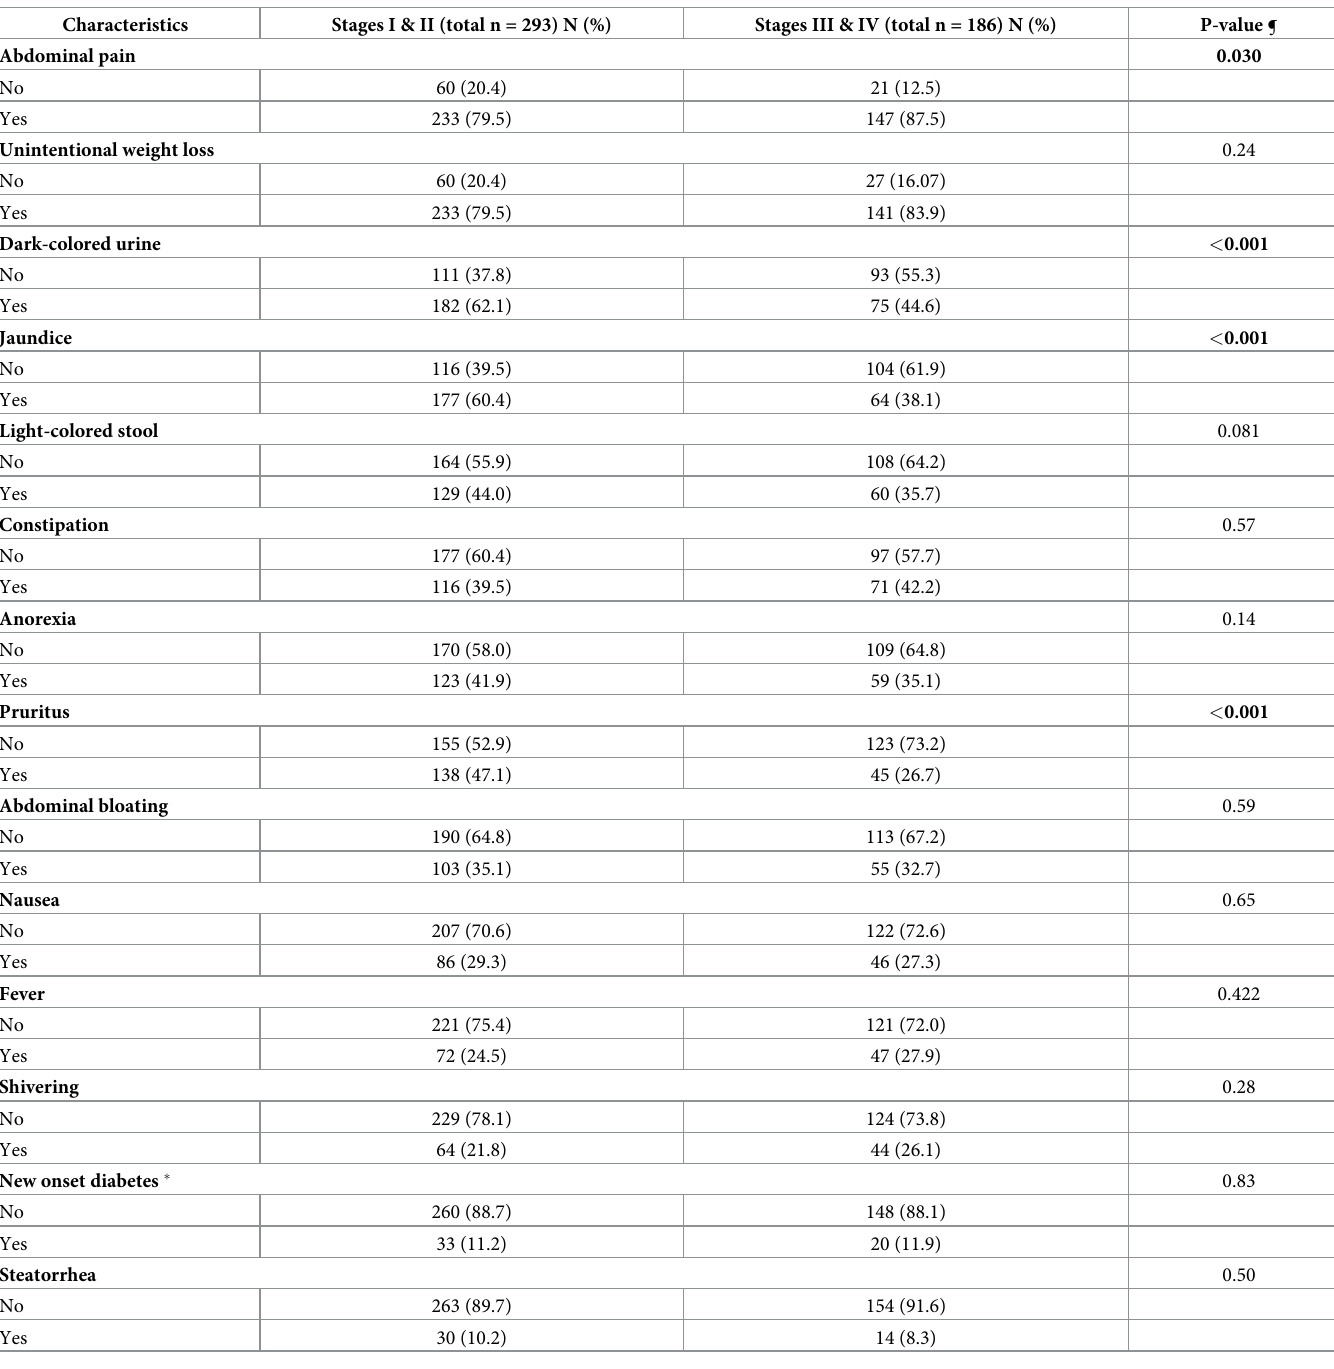
Table 3. Associations between different clinical symptoms with the tumor stage at diagnosis among Iranian patients with pancreatic ductal adenocarcinoma.